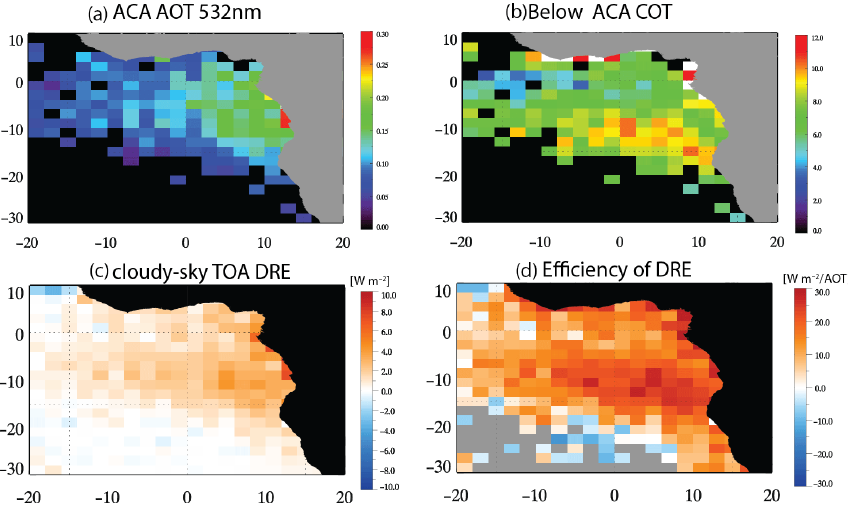
Figure 11. The 8-year seasonal mean (JJA) (a) AOT of ACA, (b) underlying COT, (c) cloudy-sky diurnally averaged DRE at TOA (Wm − 2 ) , and (d) TOA DRE efficiency (Wm − 2 AOT − 1 ) in the SE Atlantic region.